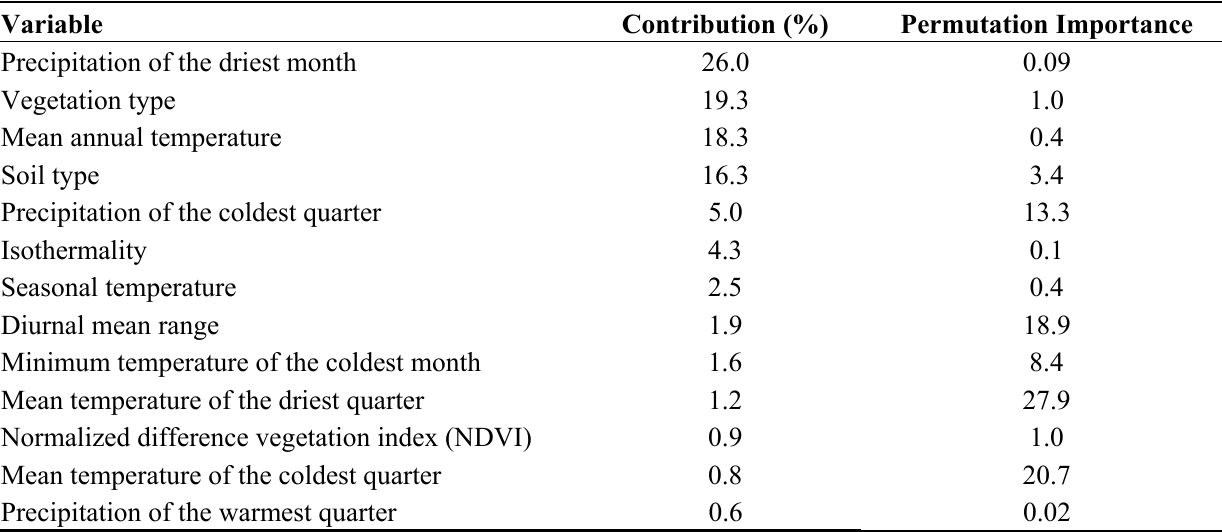
Figure 4. Jackknife of regularized training gain for Picea chihuahuana Martínez in Mexico at national scale. Bio1 = Annual Mean Temperature, Bio5 = Max Temperature of Warmest Month, Bio6= minimum temperature of the coldest month, Bio9 = Mean Temperature of Driest Quarter, Bio10 = Mean Temperature of Warmest Quarter, and Bio11 = Mean Temperature of Coldest Quarter. Table 3. Contribution of the variables to the potential distribution of Picea chihuahuana Martínez at state scale in Chihuahua,